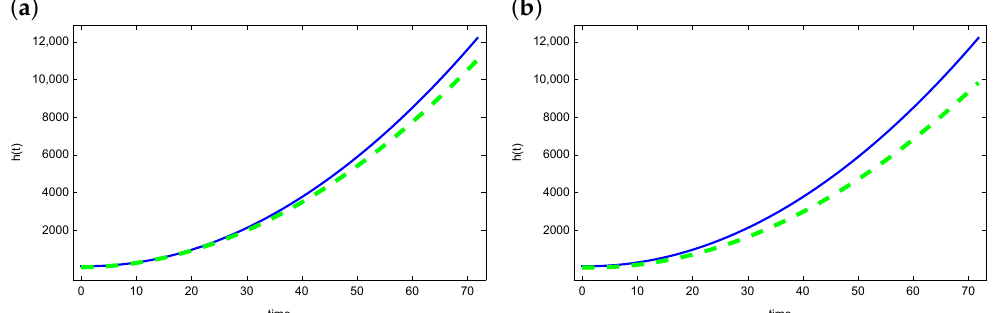
Figure 2. The exact heat transfer h ( t ) (blue line) and approximate heat transfer (dashed green line) for ( a ) ACO and ( b ) DBOA.